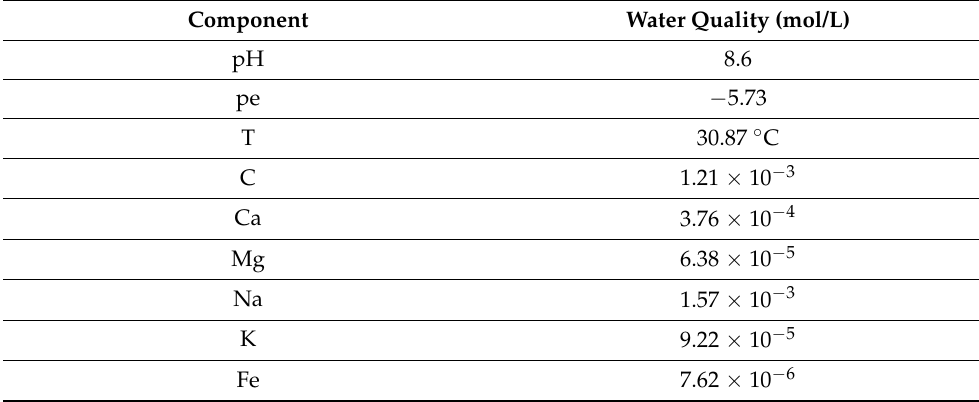
Table 4. Groundwater quality in potential radioactive waste disposal sites in